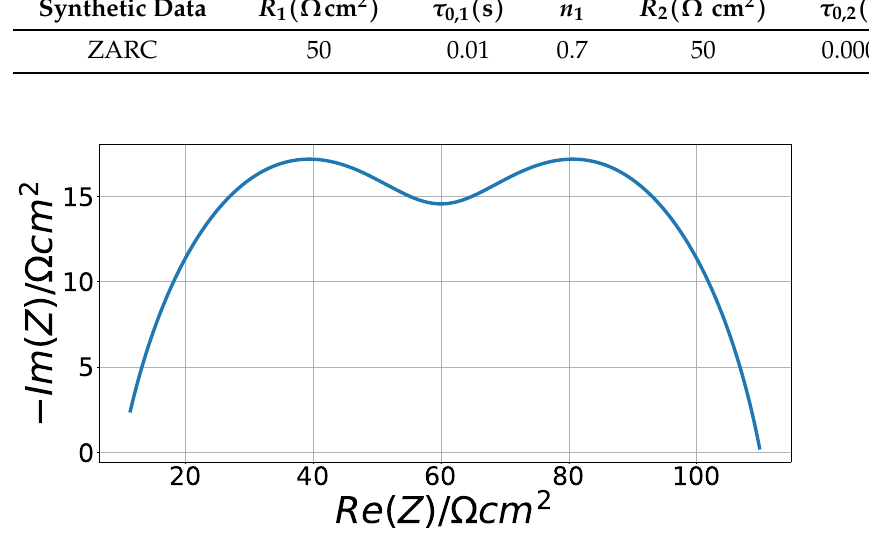
Figure 8. Double ZARC synthetic data